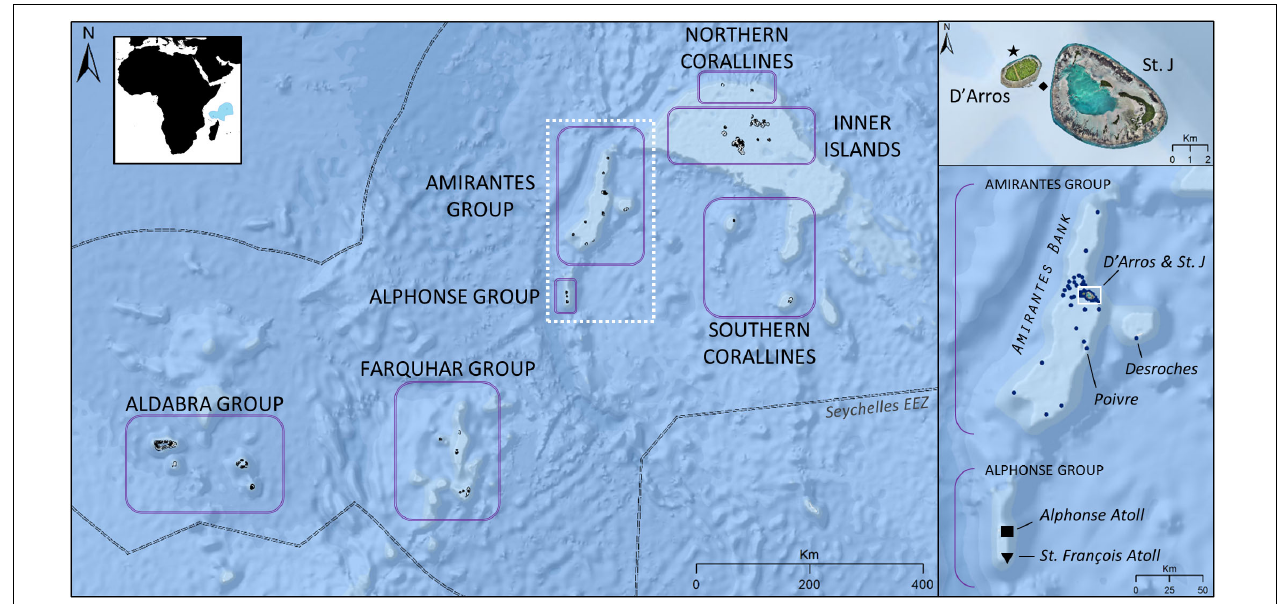
FIGURE 1 | Location of the seven Island Groups of Seychelles [Exclusive Economic Zone (EEZ) of country indicated in blue in inset map]. Reef manta rays ( Mobula alfredi ) are frequently sighted near D’Arros Island and St. Joseph Atoll (St. J) within the Amirantes Group, and at St. François Atoll within the Alphonse Group. Seventy acoustic receivers ( • ) are deployed within the Amirantes Group. Alphonse Atoll located at “ (cid:4) ”; St. François Atoll located at “ (cid:72) ”; D’Arros Island manta cleaning station located at “ (cid:70) ”; St. Joseph channel (depth 60 m) located at “ (cid:7) ”. Satellite imagery © Save Our Seas Foundation.